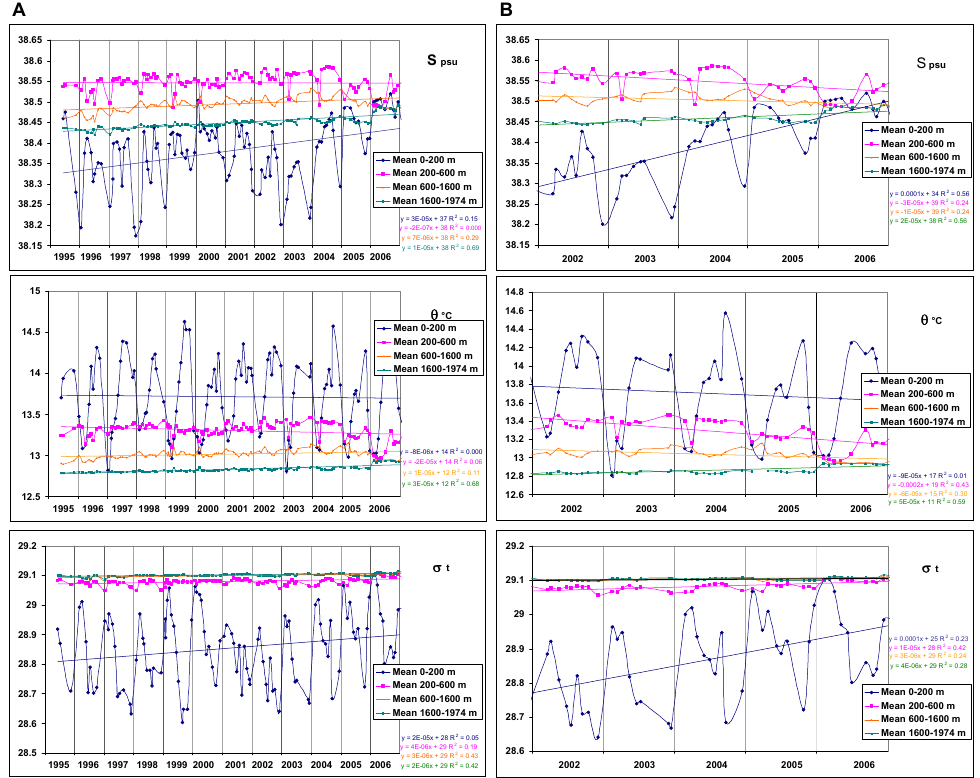
Fig. 5. (A) 1995–2006 time-series of mean salinity, mean temperature, mean density in various layers: 0–200m; 200–600m; 600–1600m, 1600–1974m. (B) Detail for 2002–2006 period. Regression lines for the 2002–2006